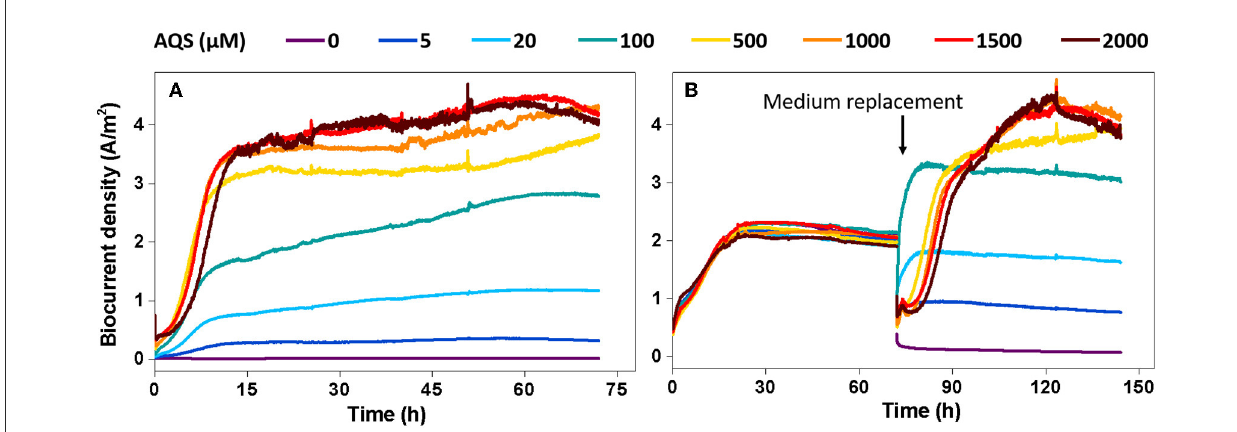
FIGURE4 Biocurrent density vs. time under two special conditions. (A) Potentiostatic incubation in the bioelectrochemical system (BES) was initiated after 9,10-anthraquinone-2-sulfonic acid (AQS) pre-reduction. (B) The biofilms were incubated in BES with 50 µ M AQS for 4 days, after which the original medium in the BES was replaced with a new medium containing different concentrations of pre-reduced AQS.